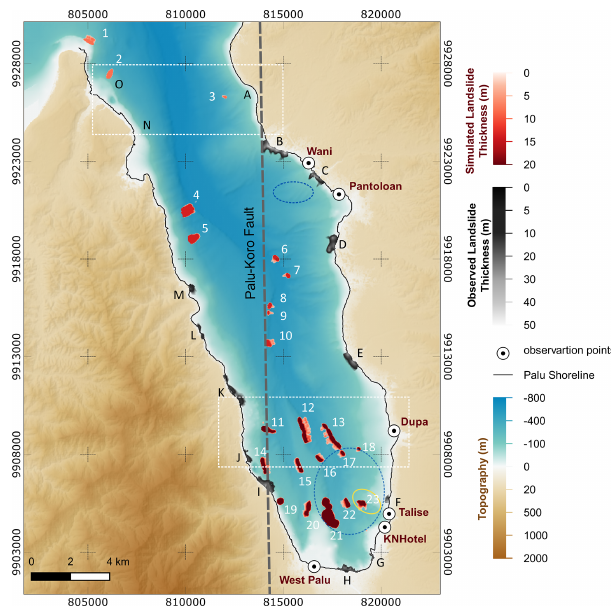
Figure 6. Simulated submarine landslides calculated based on Hov- land’s slope stability analysis in this study (landslide no. 1–23) and surveyed coastal/submarine landslides in previous literature (land- slide A–O). The white and red color bar indicates the simulated landslide thickness for each grid (27m resolution), and the black and white color bar indicates the observed landslide thickness. The dashed rectangles represent the potential submarine landslide areas proposed by Heidarzadeh et al. (2019), the dashed ellipse represents that proposed by Nakata et al. (2020), and the yellow ellipse repre- sents that proposed by Schambach et al. (2021). The dots represent the video-inferred waveform observation points. The grey dashed line represents Palu–Koro